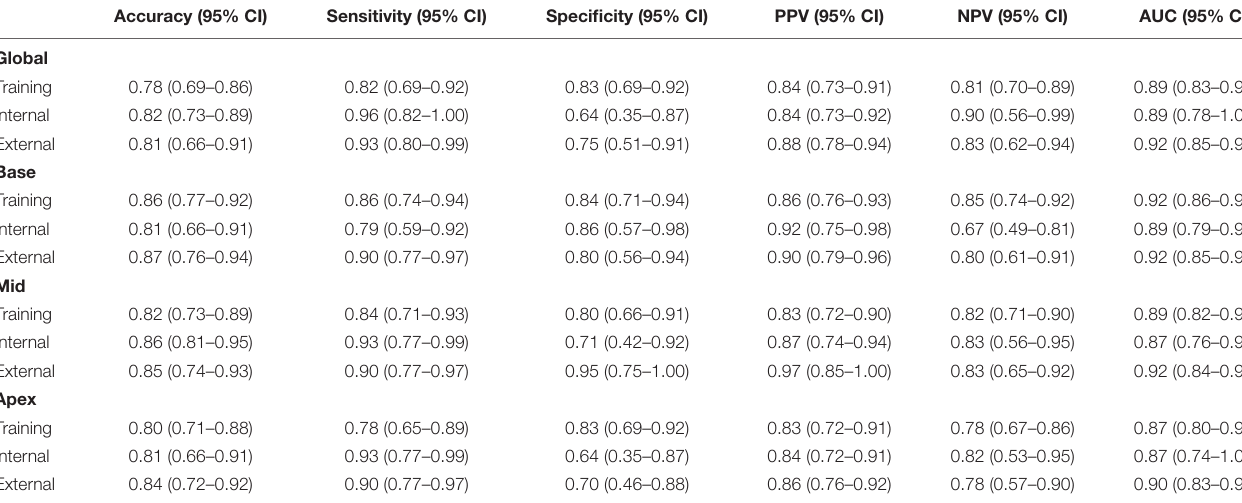
FIGURE 4 | Workflow of the development and validation of radiomics model. First, lesions are manually segmented on late gadolinium enhancement (LGE) MR images for radiomics analysis. Second, a total of 1,906 radiomics features are extracted on global myocardium and three different sections (base, mid-cavity, and apex), respectively. Third, in the training phase, Boruta algorithm is used for feature selection. Fourth, XGBoost machine learning algorithm is used for model building. Finally, in the validation phase, the model is tested in the internal data set and external data sets. TABLE 2 | The performance of radiomics model in the training, internal, and external validation data